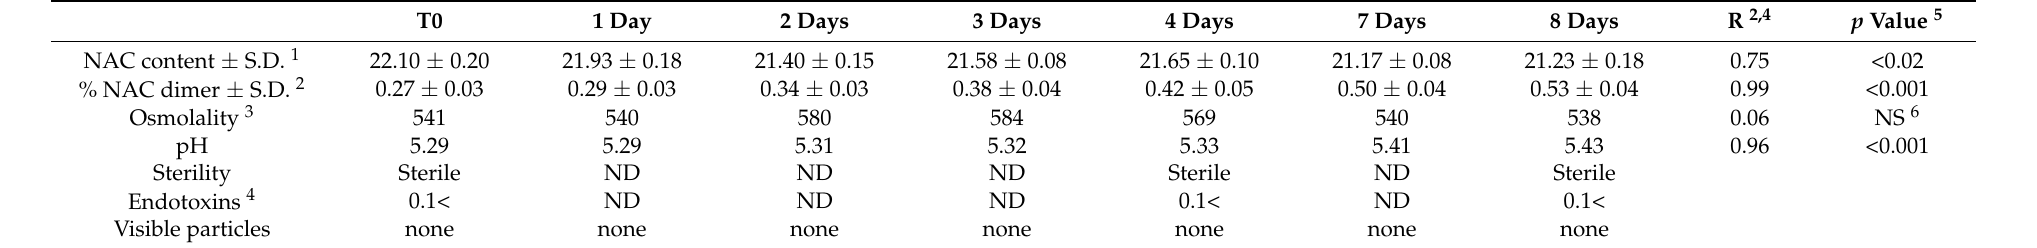
determination; 5 correlation coefficient test significance; 6 not statistically significant. Table 8. NAC + 62.5 µ g · mL − 1 zinc gluconate stability study, 25 ± 2 ◦ C ambient storage